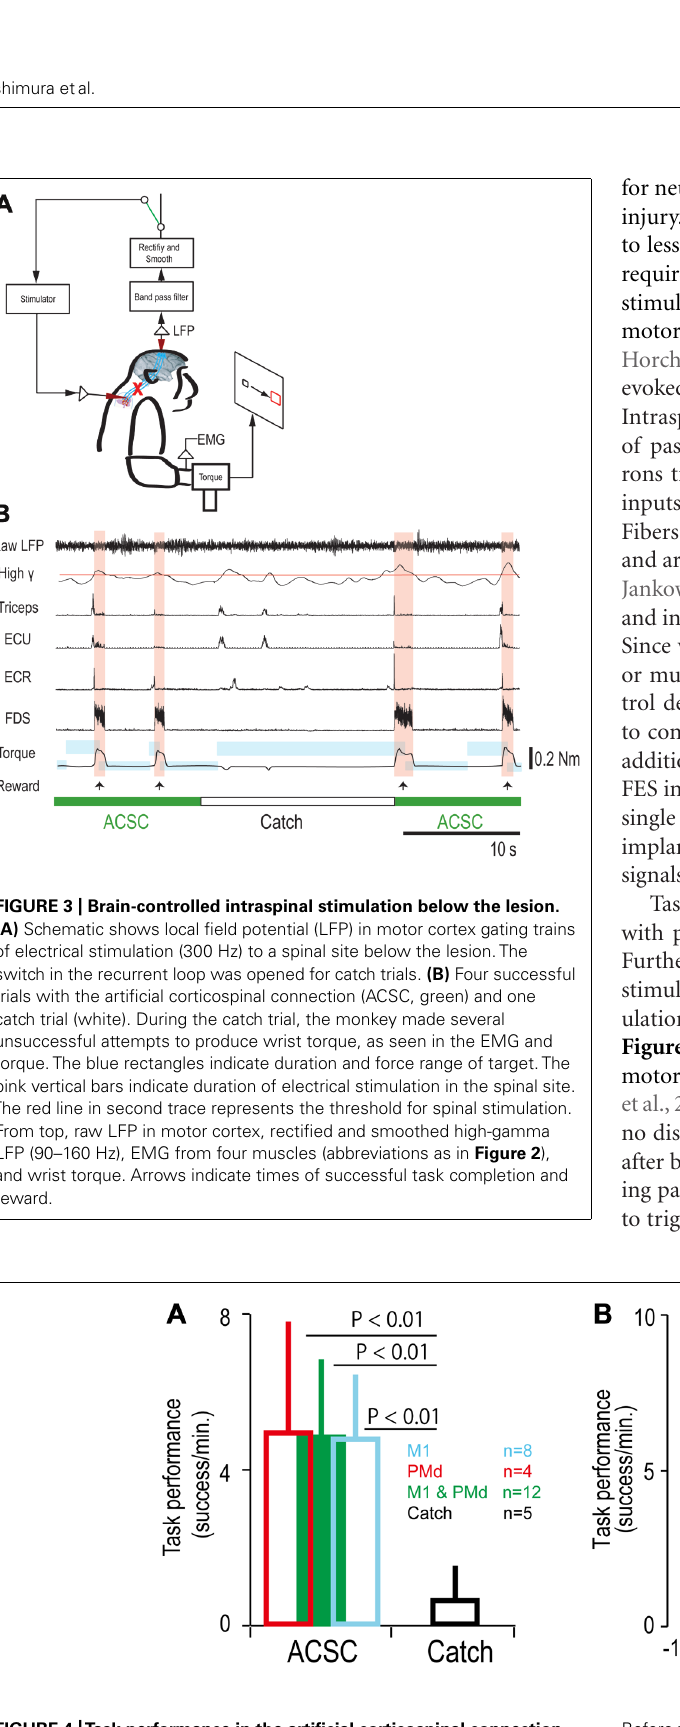
FIGURE 4 |Task performance in the artificial corticospinal connection (ACSC). (A) Average task performance with the ACSC and during catch trials. Error bars represent standard deviation. (B) Time course of task performance.